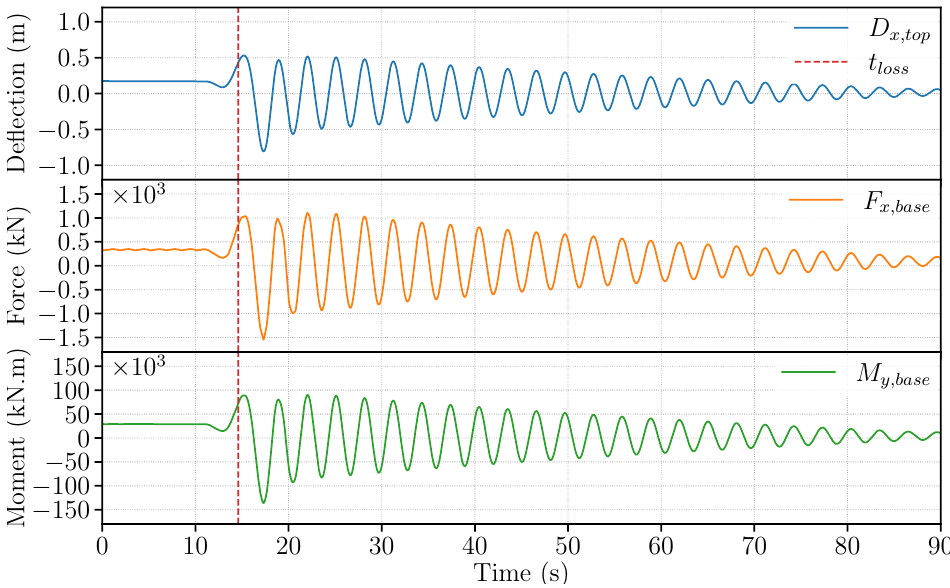
Figure 7. Wind turbine tower reactions at cut-out wind speed ( V out = 25.0m/s). The tower-top fore-aft deflection D x , the tower-base fore-aft force F x and the tower- base pitching moment M y is represented respectively by a blue line, orange line and green line in Figure 7. The red dotted line shows the instant that the grid loss occurs in the electrical network. A large change in the peak-to-peak amplitude is observed in all types of the tower reaction after the electrical fault. Since the structural damping ratio of the wind turbine tower is small (see Table A1), the energy dissipation is really weak that leads the tower to still oscillate at the end of the simulation ( t = 90 s). This exposes the need for a